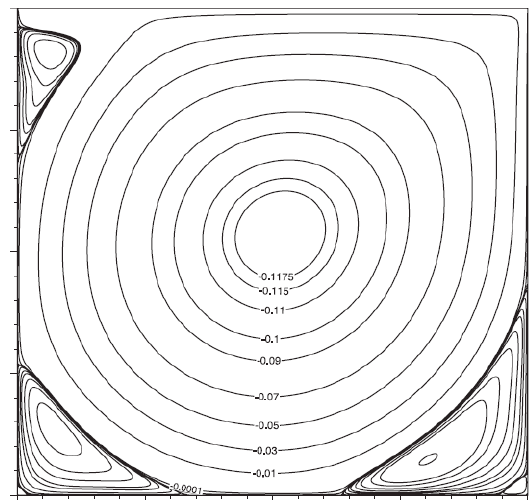
Figure 8. Comparisons of streamline patterns for Re lid = 5000 in a square cavity. ( a ) Present solutions; ( b ) Ghia et al., adapted from [37], with permission from Copyright © 1982 Published by Elsevier Inc.; ( c ) Erturk et al., adapted from [39], with permission from © Mar 11, 2005, John Wiley & Sons Ltd.